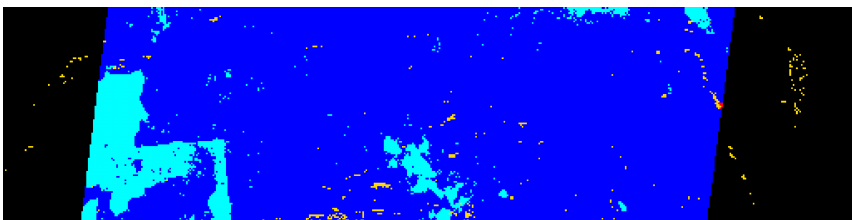
Figure 18. Map of the RCCM for Path 169, Orbit 78171, Block 102 and camera DA, regenerated on the basis of the camera BA and CA values. Linear dimensions are as described in the caption of Fig. 3. This derived product shows minimal quilting and indicates that the area is clear throughout. See text for